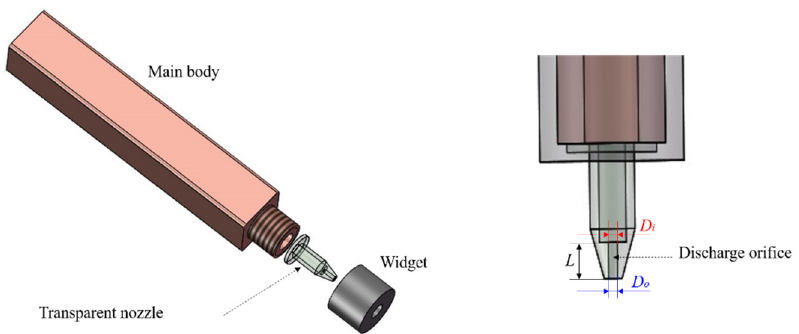
Figure 8. Structure of the single